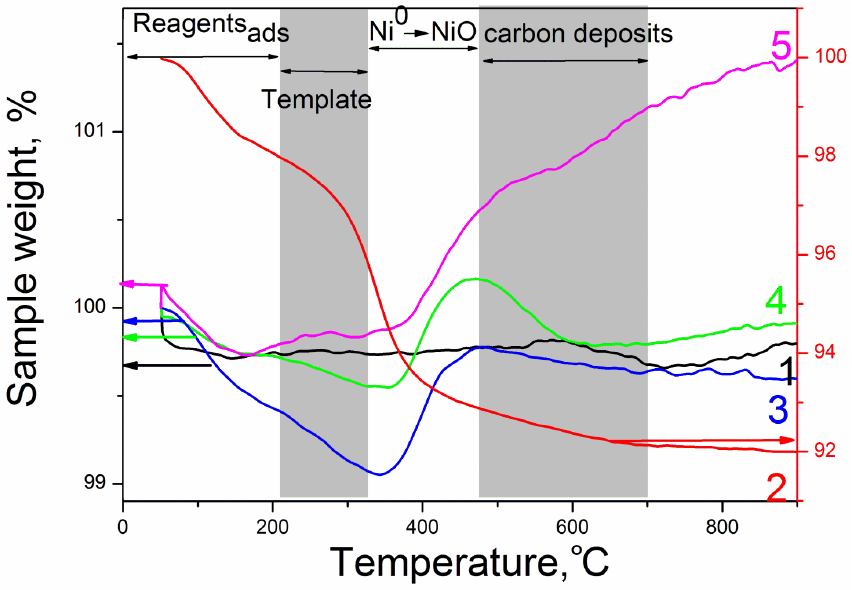
Figure 7. TGA profiles for the catalysts after the CSMR reaction at 750 °C. 1—Ni/CeMg-C-S-O; 2— Ni/CeMg-A-S-V; 3—Ni/CeMg-A-S-O; 4—Ni-Pd/CeMg-A-S-V; 5—Ni/CeMg-A-P-O.